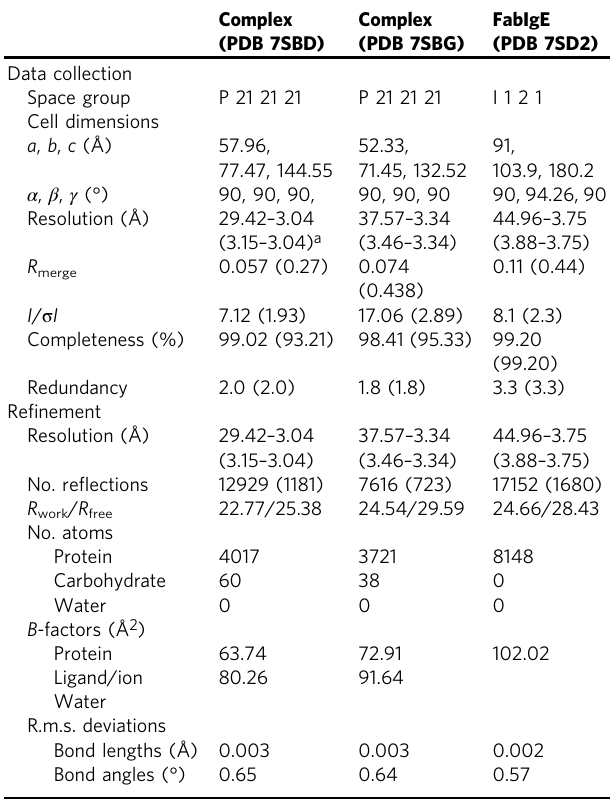
Table 1 Data collection and re fi nement statistics (molecular